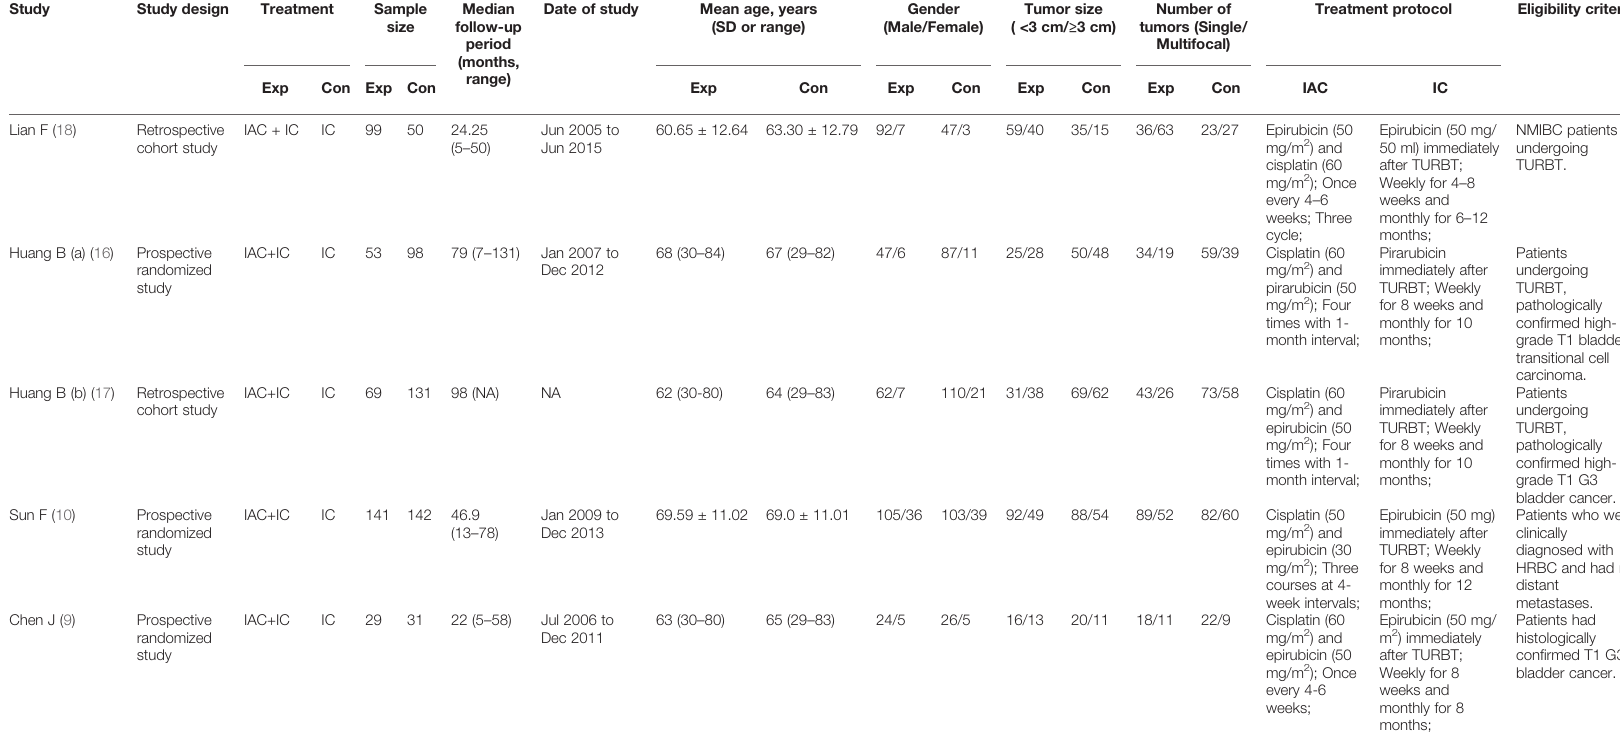
TABLE 2 | The details of each included